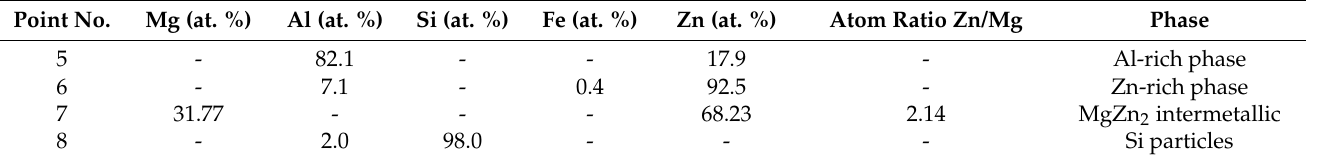
Figure 2. SEM images of the outer layer of the ZAMS coating with MgZn 2 intermetallic and Si precipitations. Table 4. Results of the EDS analysis of the outer layer of coatings and the corresponding phase (analysis points as shown in Figure 2).